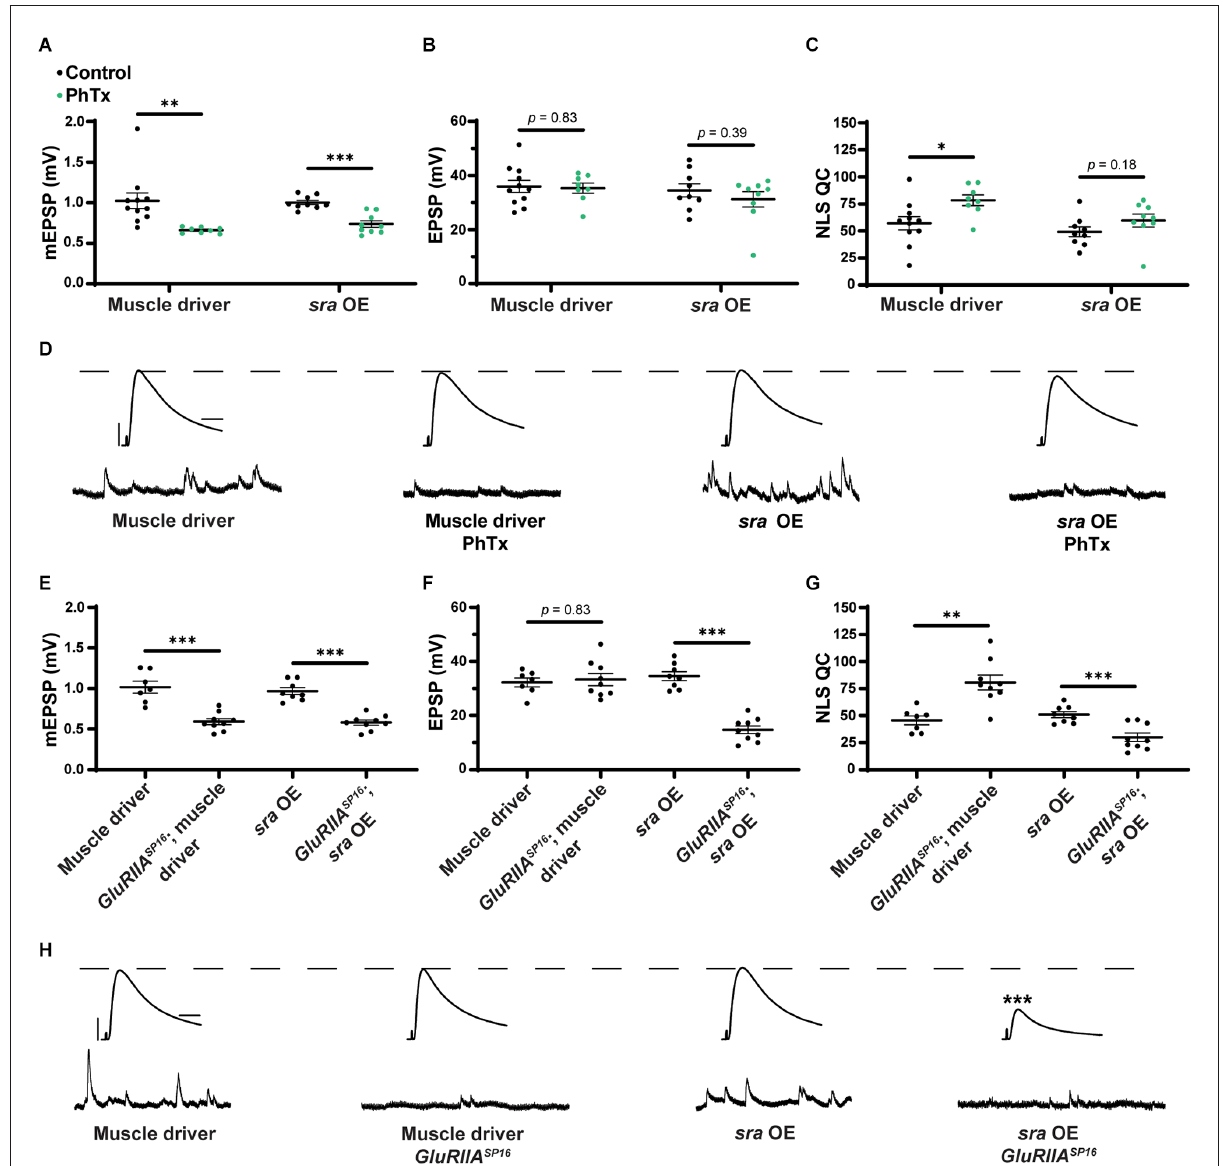
FIGURE4 Maintenance of presynaptic homeostatic potentiation is impaired by muscle overexpression of sra but an acute expression is not. (A–C) Quantification showing average mEPSP amplitude, EPSP amplitude, and NLS quantal content in post-GAL4 control and post-GAL4 driven sra overexpression (OE). Black points show DMSO control synapses, while green points show synapses treated with PhTx. (D,H) Representative electrophysiological traces of EPSPs (above) and mEPSPs (below). Scale bars for all traces are y = 10 mV (1 mV), x = 20 ms (500 ms) for EPSPs (mEPSPs). (E–G) Quantification showing average mEPSP amplitude, EPSP amplitude, and NLS quantal content in post-GAL4 control and post-GAL4 driven sra OE in both the presence and absence of GluRIIA SP 16 . ∗ p < 0.05, ∗∗ p < 0.01, ∗∗∗ p < 0.001 by Student’s T-test